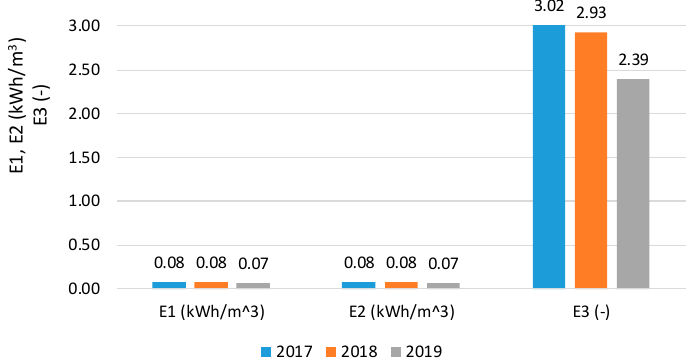
Figure 11. Performance indicators for energy efficiency (case study 1).